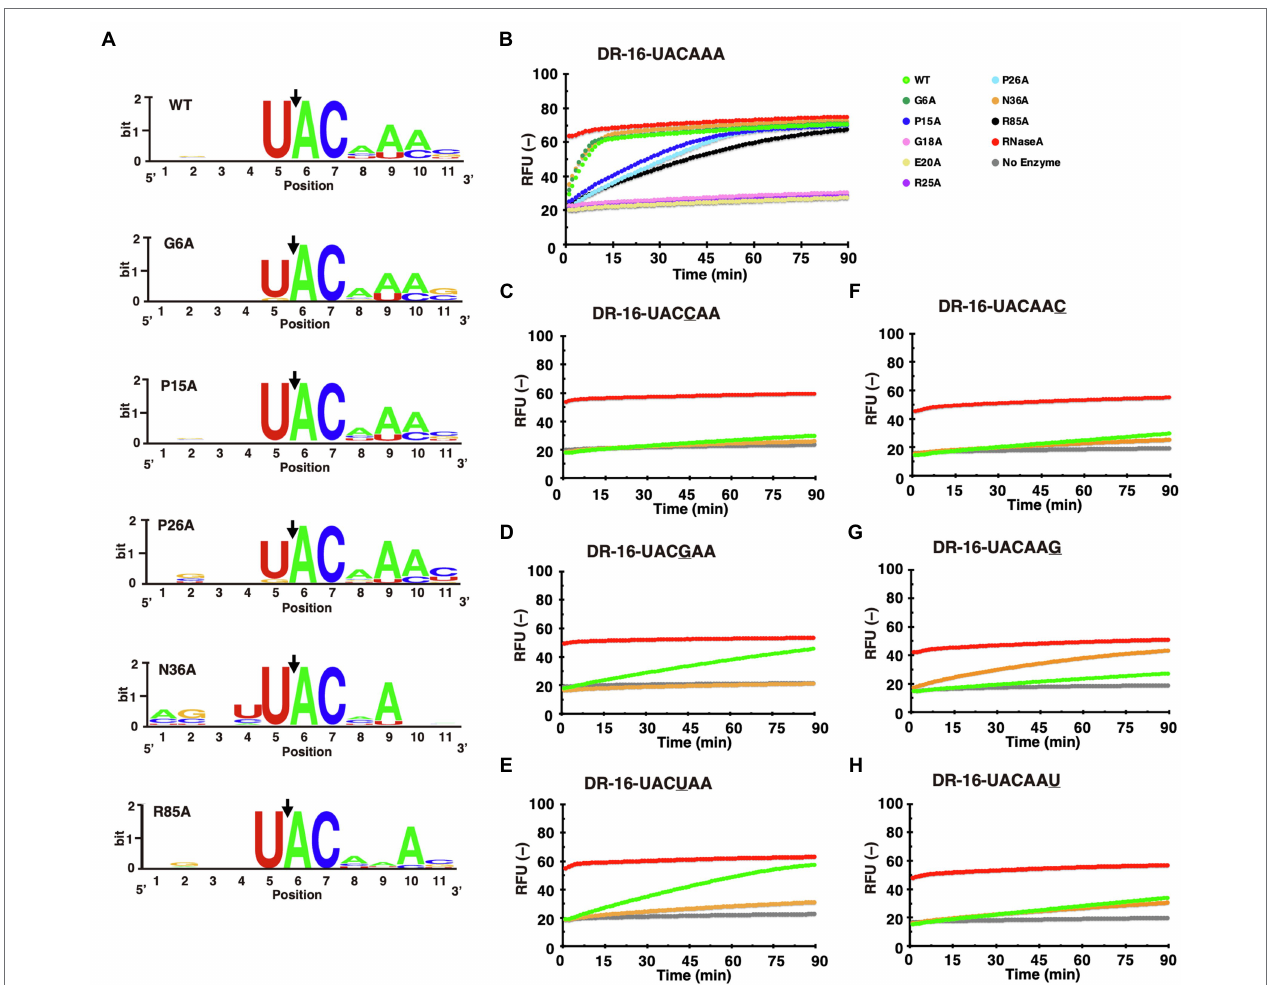
FIGURE 6 | Comparison of recognition sequences between MazF-Da mutants. (A) For comparison of the recognition sequences between MazF-Da mutants (G6A, P15A, P26A, N36A, and R85A), the ten sequences with the highest RCI values were aligned in WebLogo. Black arrows indicate the location of truncation sites. (B) The UACAAA probe was reacted with each MazF-Da mutant (G6A, P15A, G18A, E20A, R25A, P26A, N36A, and R85A) and wild-type MazF-Da, and the fluorescence intensity was continuously measured. The activity of the wild-type and of each mutant at the time point of measurement is indicated as follows: WT, light-green; G6A, green; P15A, blue; G18A, pink; E20A, yellow; R25A, purple; P26A, sky blue; N36A, orange; R85A, black; RNase A, red; No enzyme, gray. Each fluorescent probe (C–H) was reacted with wild-type MazF-Da and the N36A mutant, and the fluorescence intensity was measured continuously. (C) DR-16- UACCAA, (D) DR-16-UACGAA, (E) DR-16-UACUAA, (F) DR-16-UACAAC, (G) DR-16-UACAAG, and (H)